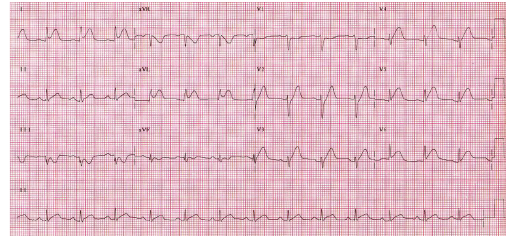
Figure 1: ECG showing ST elevation in the anterolateral leads.